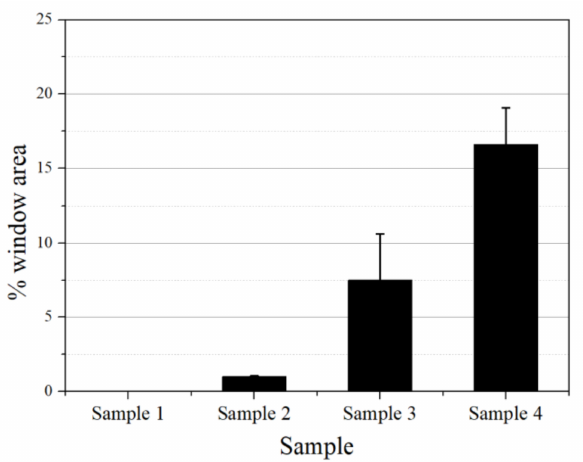
Figure 10. The % windows determined by the grayscale pixel count on 100 µ m whole pipe cross- section shavings under monochromatic cross-polarized